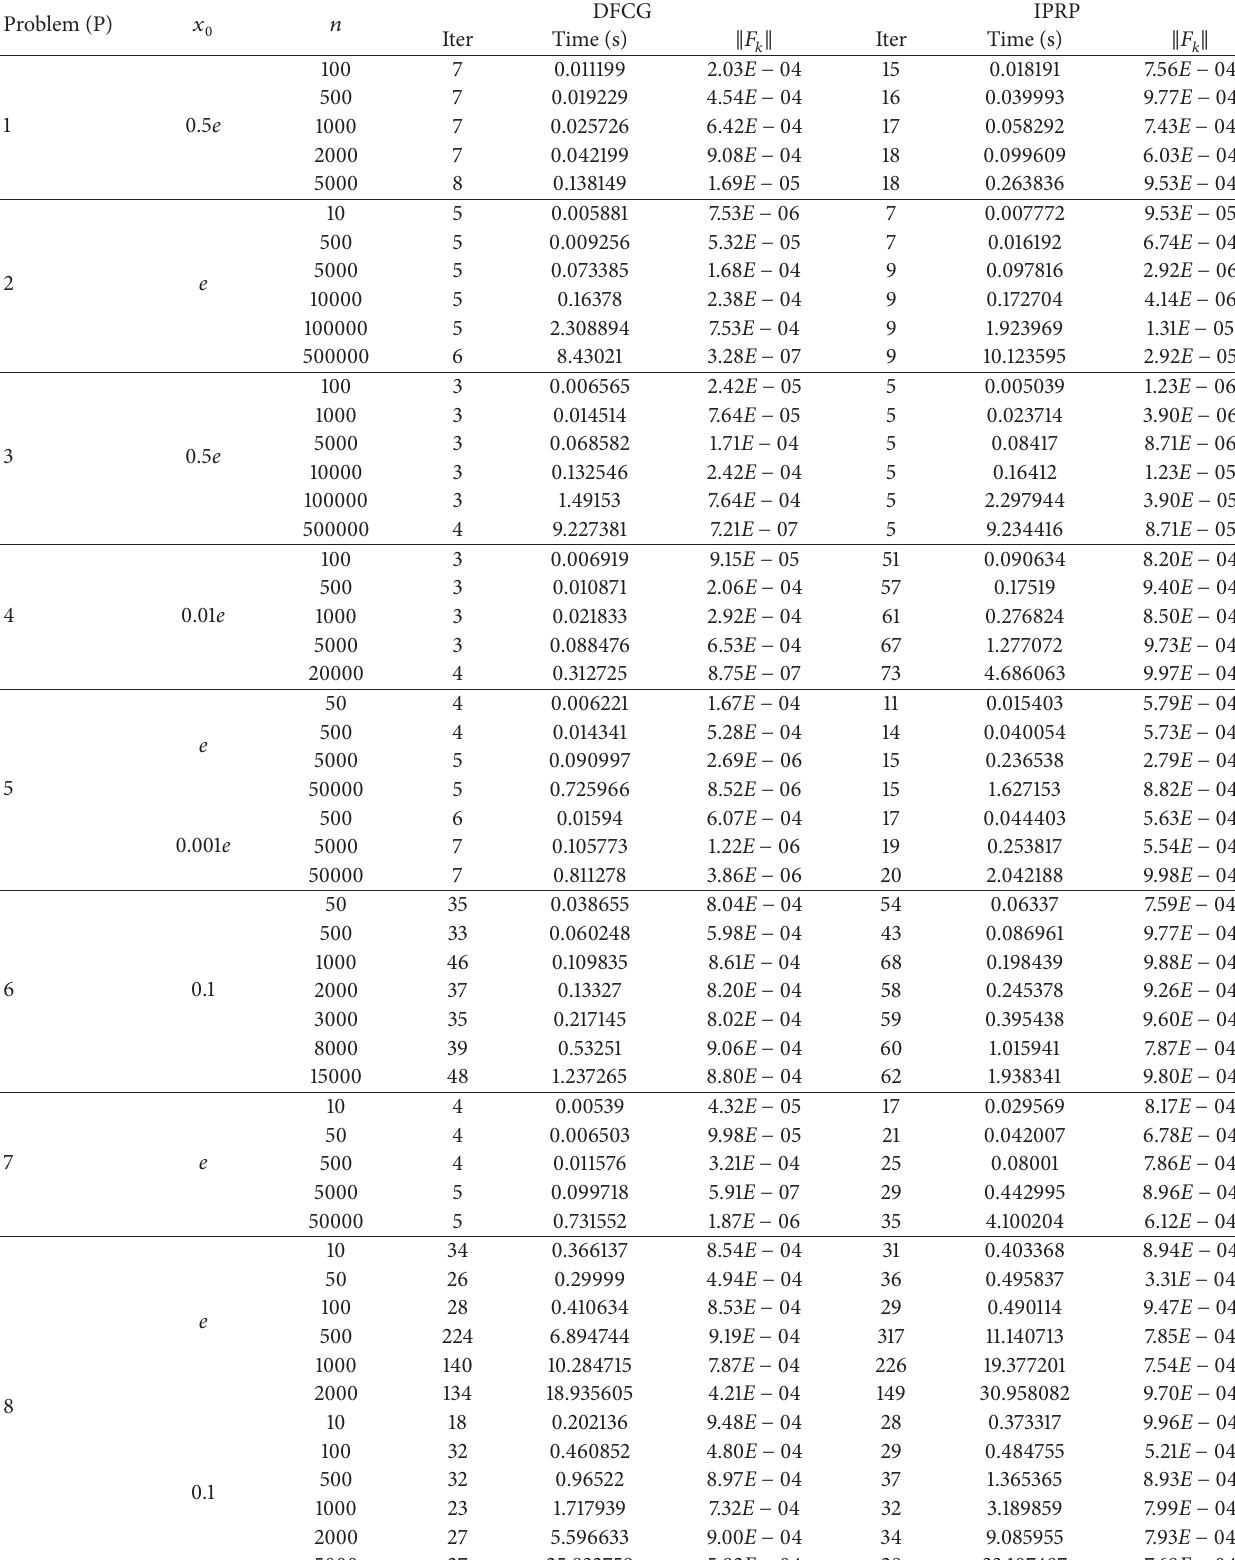
Table 1: Test results for the two methods, where 𝑒 = ones( 𝑛 ,